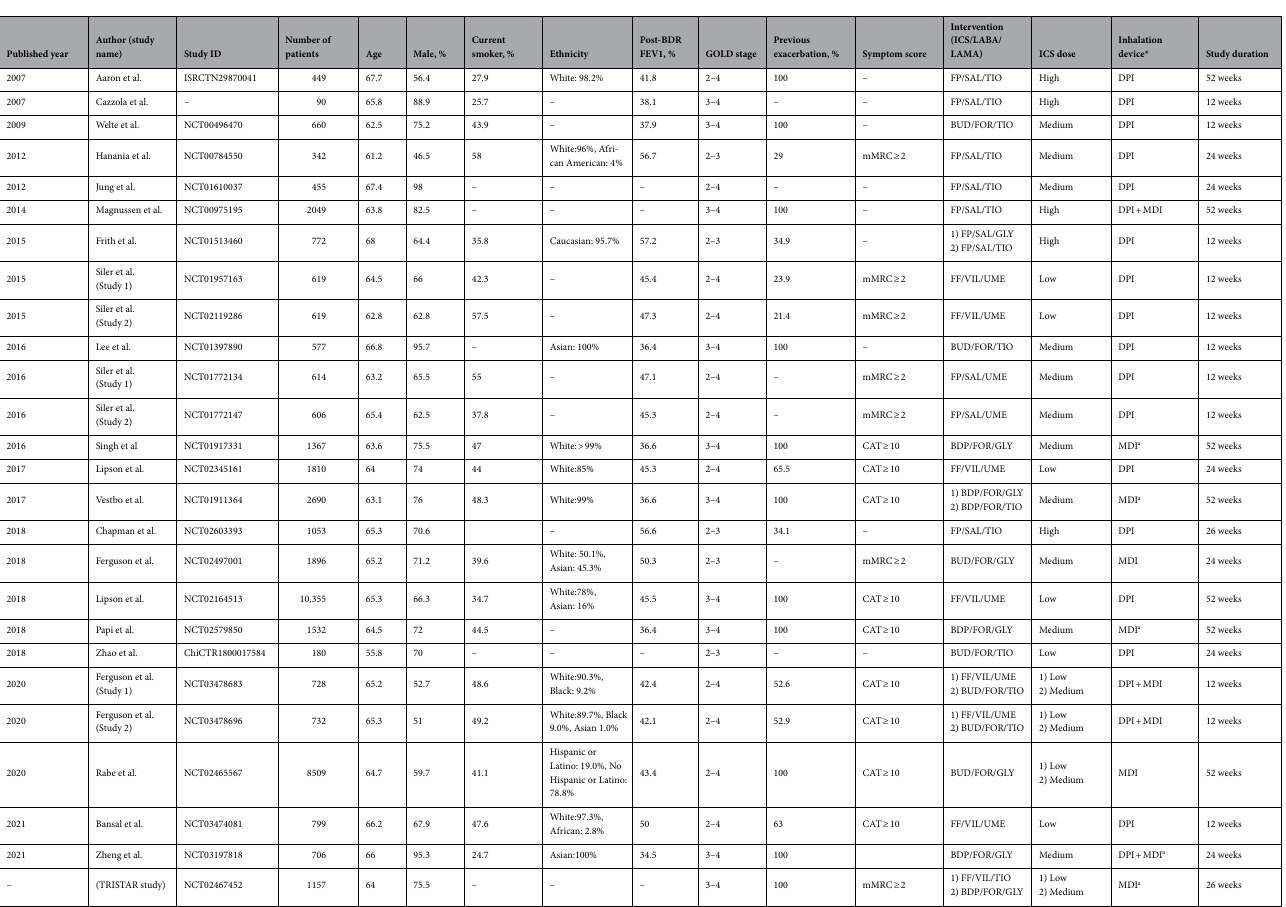
Table 1. Baseline characteristics of the 26 included studies. ID: identifier; BDR: bronchodilator; CAT: COPD assessment test; mMCRC: modified Medical Research Council; FEV 1 : forced expiratory volume in one second; GOLD : Global Initiative for Chronic Obstructive Lung Disease; ICS: inhaled corticosteroid; LABA: long- acting beta-agonist; LAMA: long-acting muscarinic antagonist; DPI: dry powder inhaler; MDI: metered